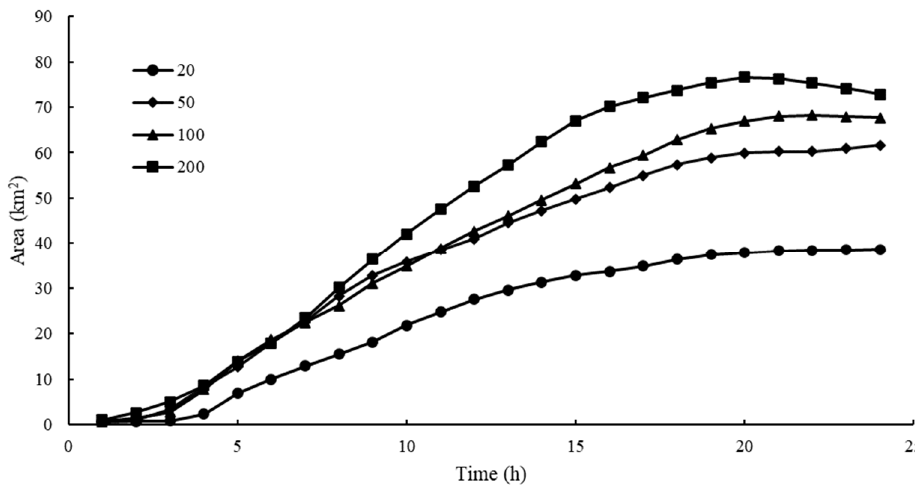
Figure 6. The dynamic change of submerged area of different frequency floods.